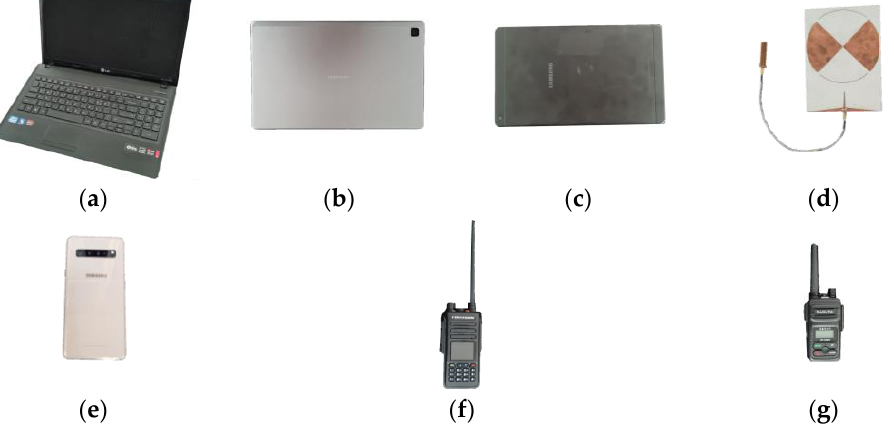
Figure 3. Various sizes of electronic targets that were used for measurement: ( a ) laptop, ( b ) tablet PC 2, ( c ) tablet PC 1, ( d ) diode-terminated antenna, ( e ) cell phone, ( f ) radio 2, and ( g ) radio 1.